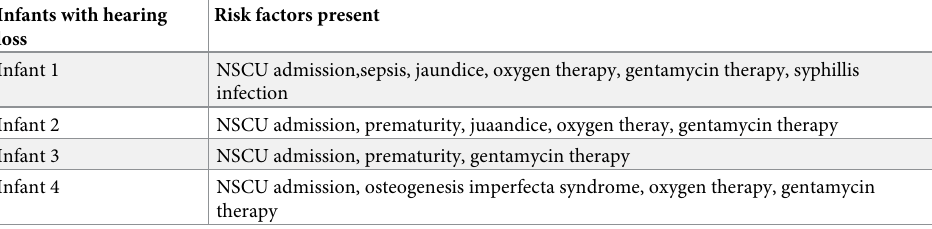
Table 2. A figure showing distribution of risk factors among the infants with hearing loss. Infants with hearing